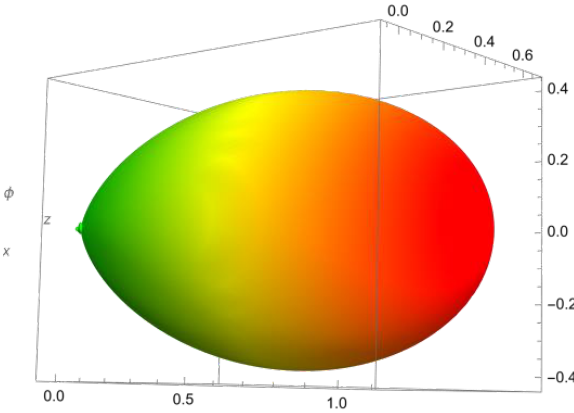
Figure 8. Azimuth view of the formed narrow beam.